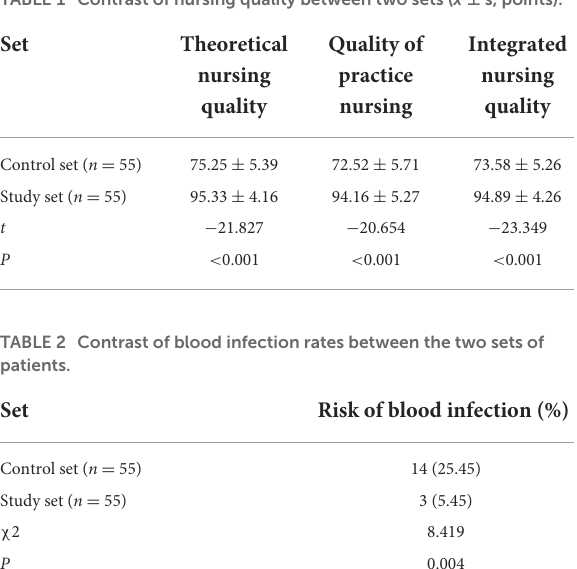
TABLE 1 Contrast of nursing quality between two sets ( ¯ x ± s, points).